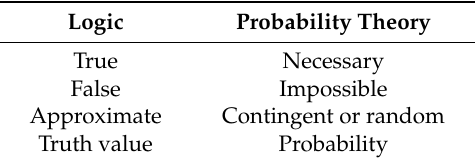
Figure 1. Quantum probability amplitudes. The probability amplitudes are summed as the forces: r 1 and r 2 are summed, with a maximum when the angle is 180 ◦ . s 1 and s 2 are subtracted, and are voided if its modulus is the same. Table 1. Isomorphism between a disjunctive logic and probability theory.